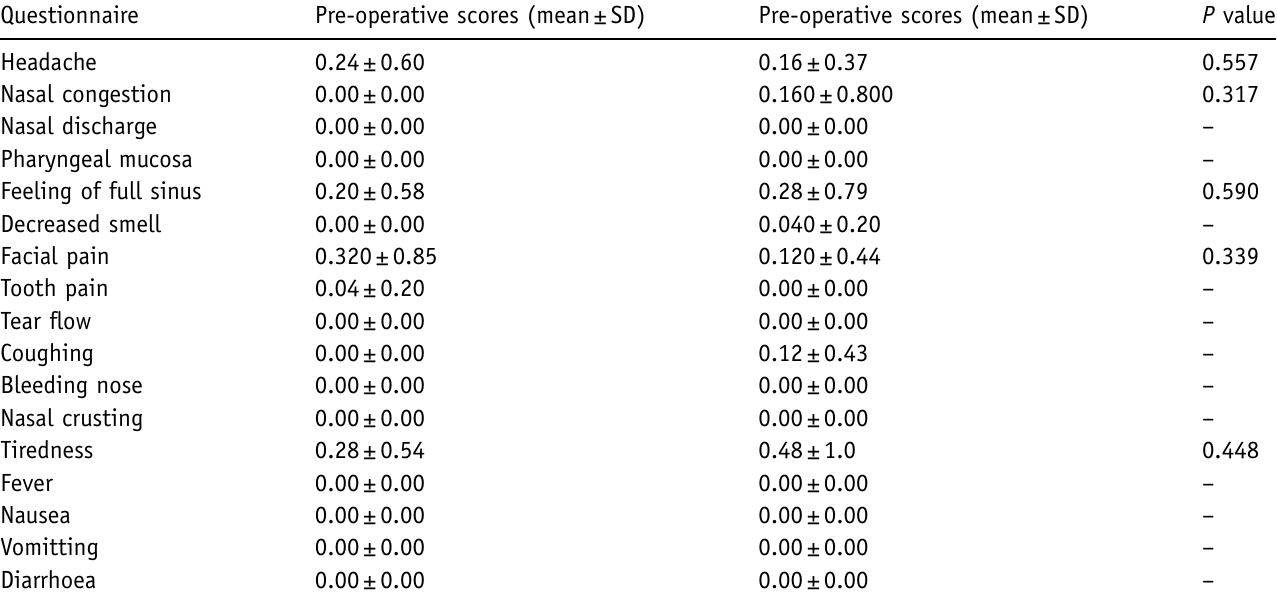
Table III. VAS questionnaire (Wilcoxon sign rank test).